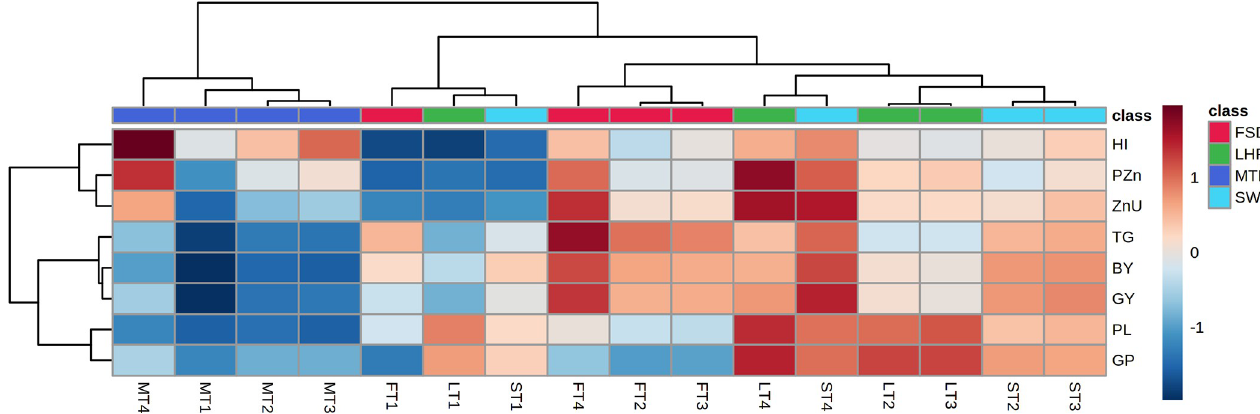
Fig 5. Heatmap showing comparison of treatments among various experimental locations for rice. M = Multan; F = Faisalabad; S = Sahiwal; L = Lahore; BAZU = Bioactive Zn coated urea (42% N; 1% Zn); T 1 (Urea 46% N @ 185 kg ha -1 + zero Zn), T 2 (Urea 46% N @ 185 kg ha -1 + ZnSO 4 33% Zn @ 15 kg ha -1 ), T 3 (BAZU 42% N @ 100 kg ha -1 + Urea 46% N @ 62 kg ha -1 + 1% bioactive Zn @ 1.00 kg ha -1 ), T 4 (BAZU 42% N @ 125 kg ha -1 + Urea 46% N @ 62 kg ha -1 + 1% bioactive Zn @ 1.25 kg ha -1 )HI = Harvest index; PZn = paddy Zn concentration; ZnU = Zn uptake by paddy; TG = thousand paddy weight; BY = biomass yield; GY = paddy yield; PL = panicle length; GP = number of grains per panicle.